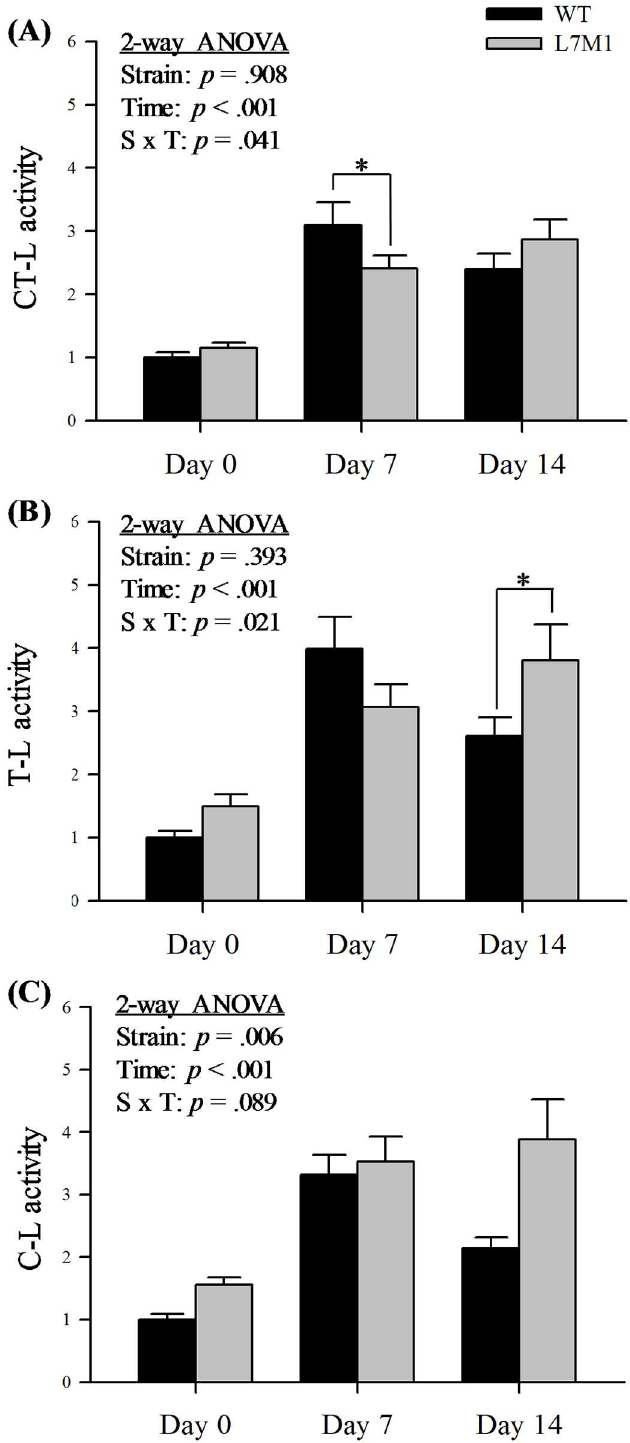
Fig 5. Proteasome enzymatic activities in WT and L7M1 mice with denervation. Results are presented as the fold change comparedto WT Day 0 for proteasome enzymatic activity in each experimental group. Two-way ANOVA was used to detect the effect of strain (WT vs. L7M1) and time (Day 0, 7, and 14) for (A) Chymotrypsin- like (CT-L) activity, (B) Trypsin- like (T-L), and (C) Caspase-like (C-L) activity (# indicates significanteffect of strain/time/S x T interactions, p < .05). When an effect of interaction was detected,